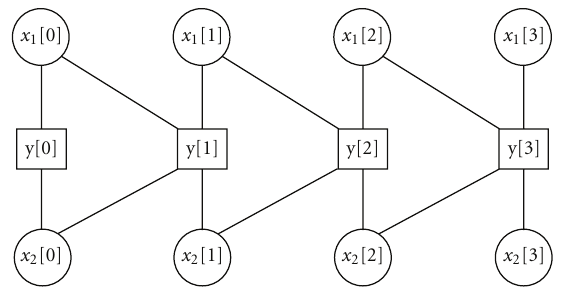
Figure 6: Factor graph of a MIMO-ISI channel with grouped joint Gaussian approximation, N T = 2, L = 1.